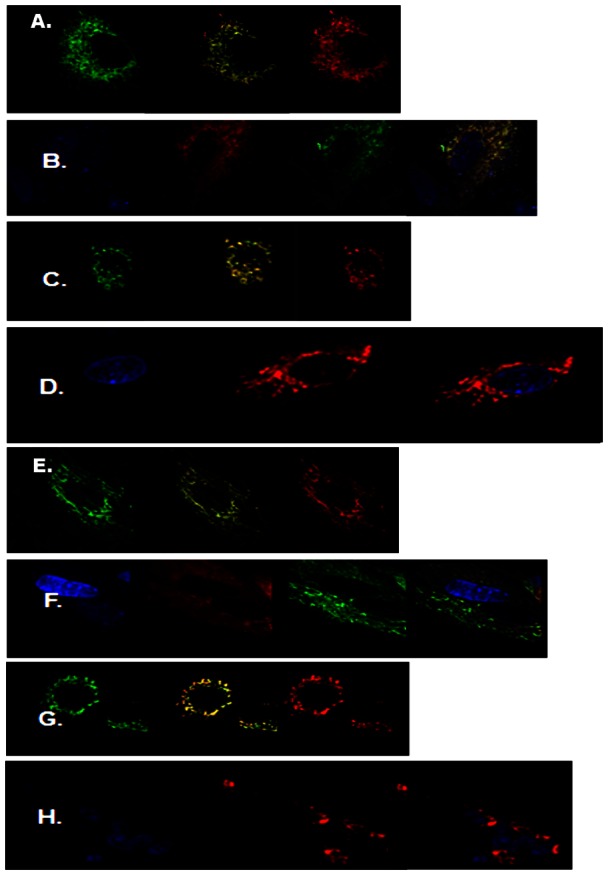
Mitochondrial staining with MitoTracker® green (total mitochondria) and MitoTracker red® (active function mitochondria) shows different morphology in cells at a given time indicative of rapid changes in movement and mitochondrial function as exemplified by the saline controls (A, B, C and D).Anterograde mitochondrial movement (away from the cell nuclei) was observed after treatment with 20 µM lithium (E) and 50 µM Paliperidone (F) as indicated by long filamentous mitochondria. Ballooning and concentration around cell nuclei (blue) was observed after treatment with 50 µM Clozapine (G). Detrimental effects were observed in mitochondria after treatment with 50 µM Haloperidol (H). Superimposed images shown in yellow.